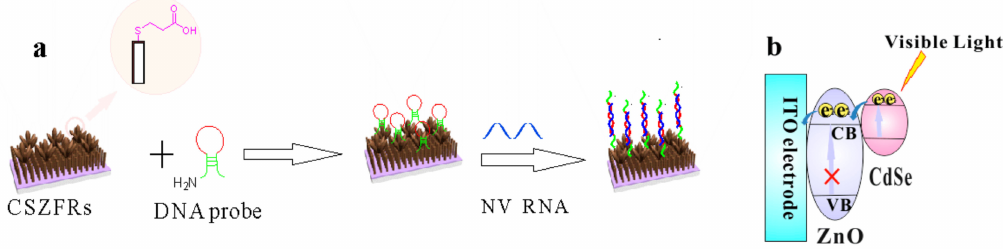
Figure 1. Schematic illustration of ( a ) the synthesis process and ( b ) electron transfer of CSZFRs based PEC